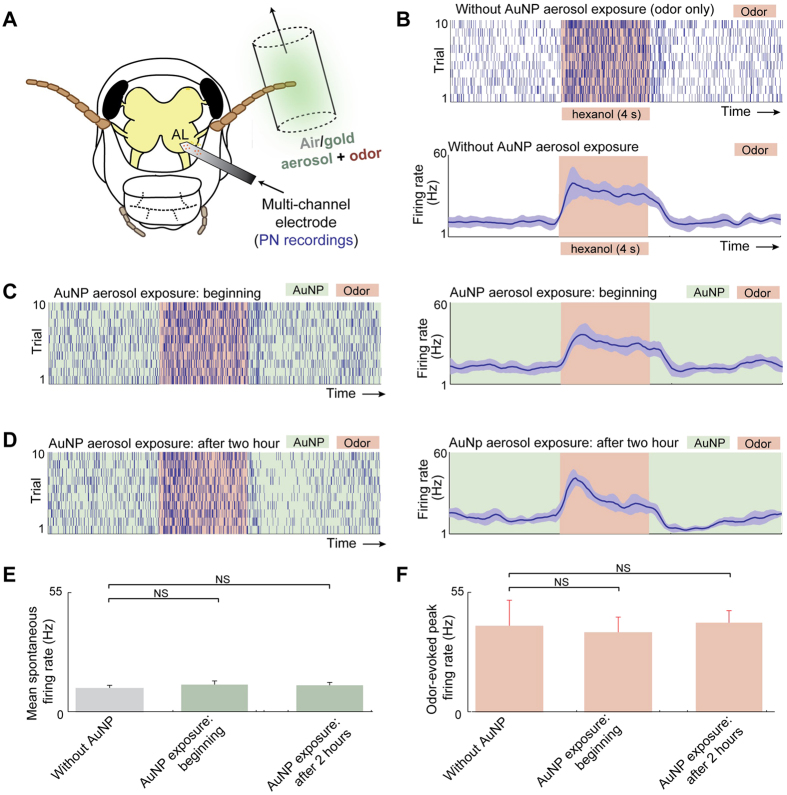
Electrophysiological characterization of bio-interactions of AuNPs.(A) Schematic of the odor/AuNP delivery and recording setup is shown. An odorant (hexanol 1%) was delivered atop a dry air or a gold nanoparticle aerosol background. The extracellular recording was made to monitor the responses of the principal neurons (or projection neurons; PNs) in the antennal lobe (AL). (B)
Top, raster plot showing spiking activity recorded from an ensemble of neurons in the vicinity of the recording electrode. The 4 s duration of odor exposure is shown as a shaded orange box. Bottom, mean spiking activity in 100 ms time segments are shown after averaging across 10 trials. Error bars (shown in light blue) represent ± S.D. over trials. (C) Similar spiking and firing rate plots as in panel (B) but revealing responses of the same set of neurons immediately following the onset of AuNP aerosol exposure. (D) Similar plots as in panel (B,C) but now showing the population PN responses after 2 hours of continuous AuNP aerosol exposure. (E) A comparison of mean ± S.D of spontaneous neural firing rate (baseline spiking activity in a 5 s window without any odor exposure) is shown. Note that spike rates across three conditions are statistically comparable to each other (paired t-test, NS when p > 0.01, n = 10). (F) Similar analyses but comparing activity during the odor puff in all three conditions. Again the differences in spiking activities are insignificant across the three conditions (paired t-test, NS when p > 0.01, n = 10).